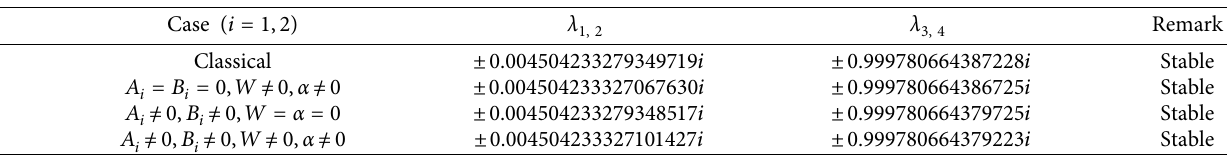
Table 2: Effects of radiation pressure factor, P–R drag, and dynamical flattening parameters on the stability of triangular equilibrium points L of the Sun-Earth system. 4 , 5